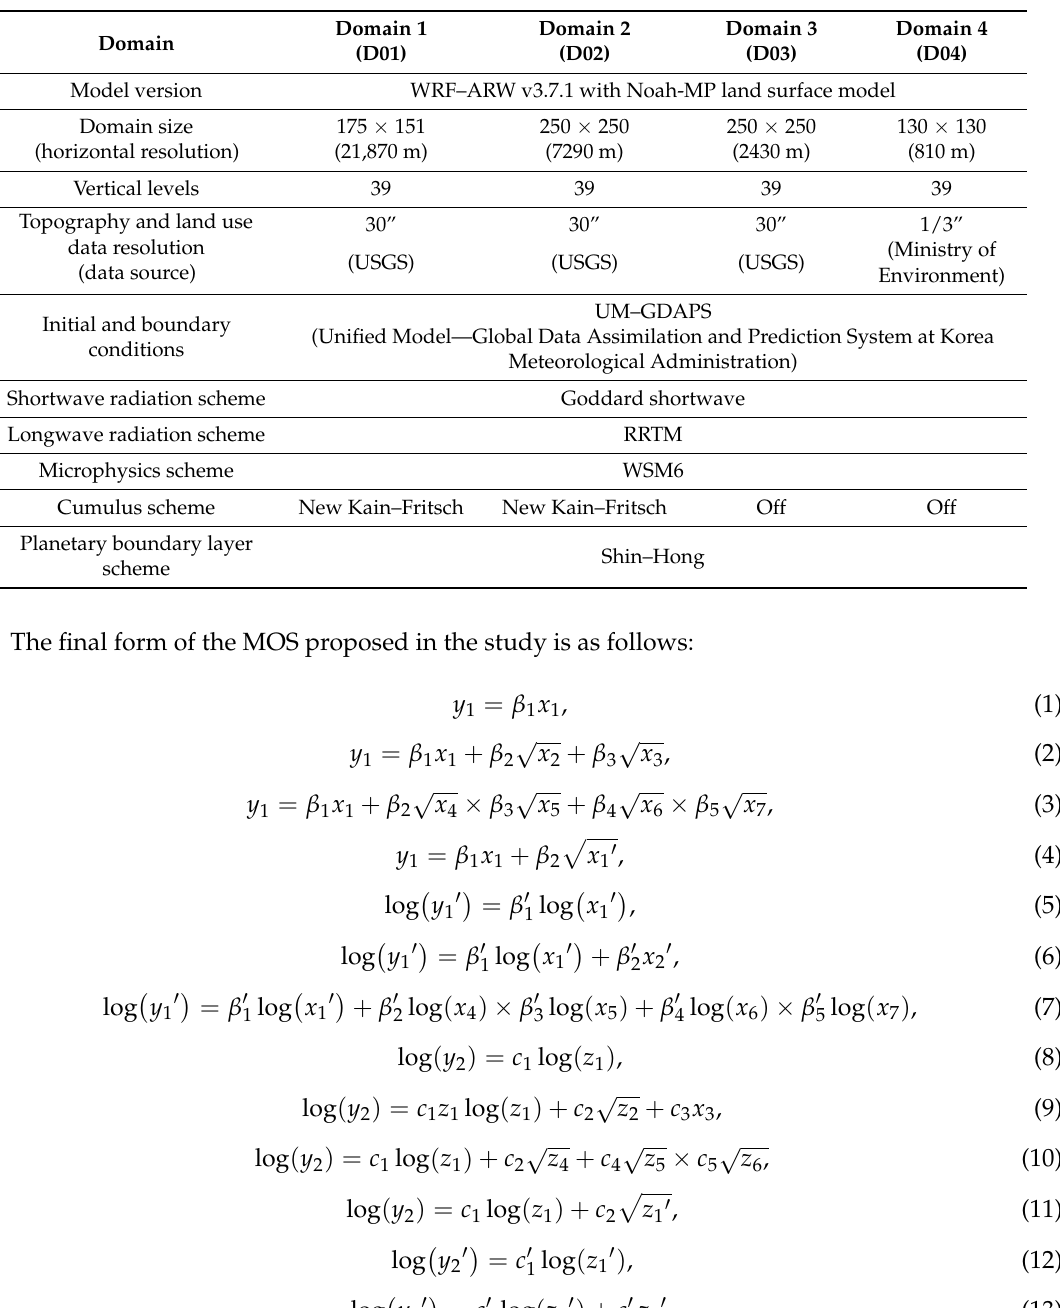
Table 1. NCAM–LAMP WRF/Noah-MP model (version 1.5)